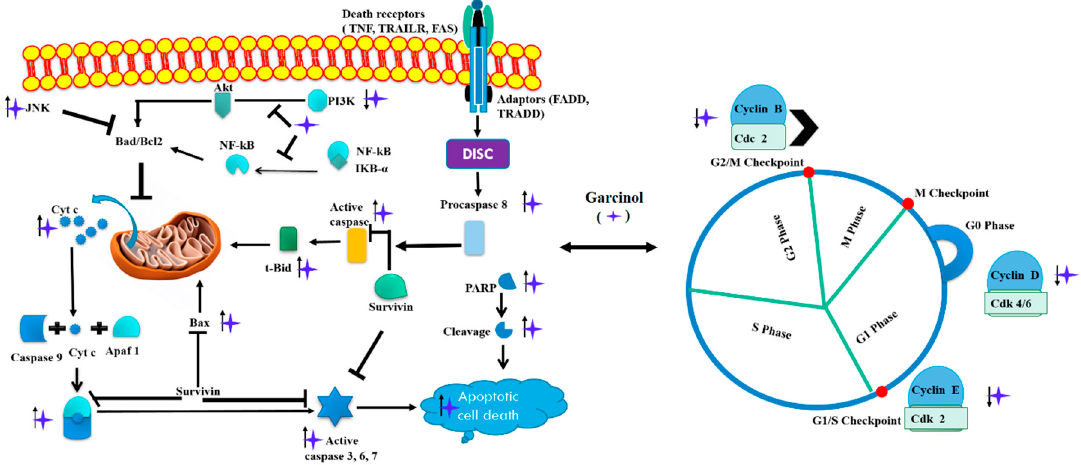
Figure 2. Schematic representation of apoptosis with garcinol treatment ( ↑ up regulation, ↓ down regulation ). Garcinol leads to cell cycle arrest in G0, G1 / S, and G2 / M phase via regulating binding of CDKs and cyclin molecules (Cyclin B, D and E) respectively. Garcinol leads to apoptosis via PI3K/AKT and NF- κ B signaling pathways, PARP cleavage and activation of caspases. Phosphoinositide 3-kinase (PI3K), AKT serine / threonine kinase (Akt), cyclin-dependent kinases (CDKs), poly(ADP-ribose) polymerase (PARP), nuclear factor kappa B (NF- κ B), Bcl-2 associated X, apoptosis regulator (Bax), inhibitor of kappa B (I κ B- α ), Cytochrome c (Cyt c), Cyclin dependent kinase 1 (Cdc2), ppoptotic protease activating factor 1 (Apaf-1), truncated BH3 interacting domain death agonist (tBid), Bcl-2 associated agonist of cell death (Bad), B-cell lymphoma 2 (Bcl-2), c-Jun N-terminal kinase (JNK).